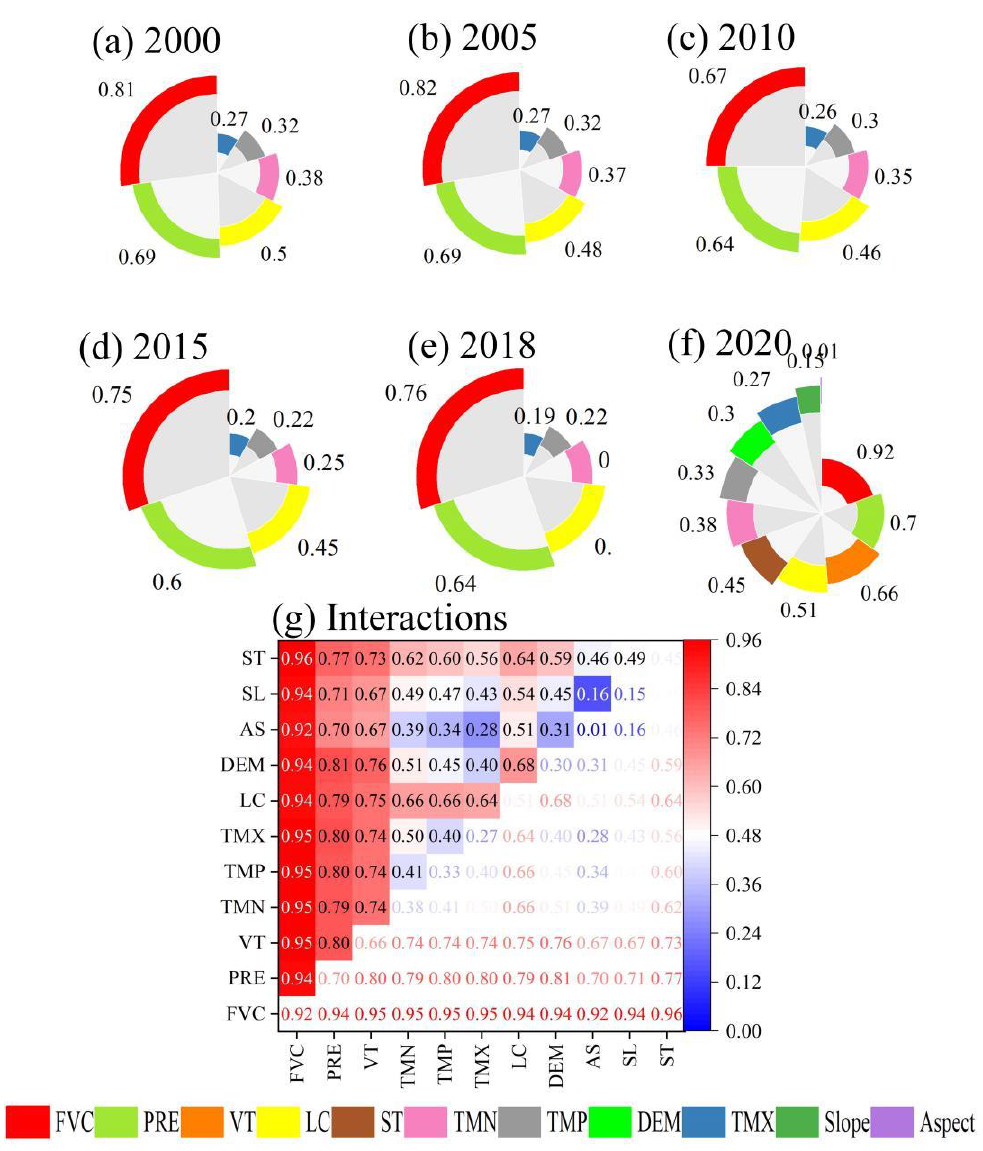
Figure 7. Contributions of driving factors and their interactions to spatial distribution of SM from 2000 to 2020: ( a ) 2000, ( b ) 2005, ( c ) 2010, ( d ) 2015, ( e ) 2018, ( f ) 2020, ( g ) interactions. The numbers indicated the q values. All q values were statistically significant ( p < 0.05). Note: VT, ST, DEM, SL, and AS in other years were missing.